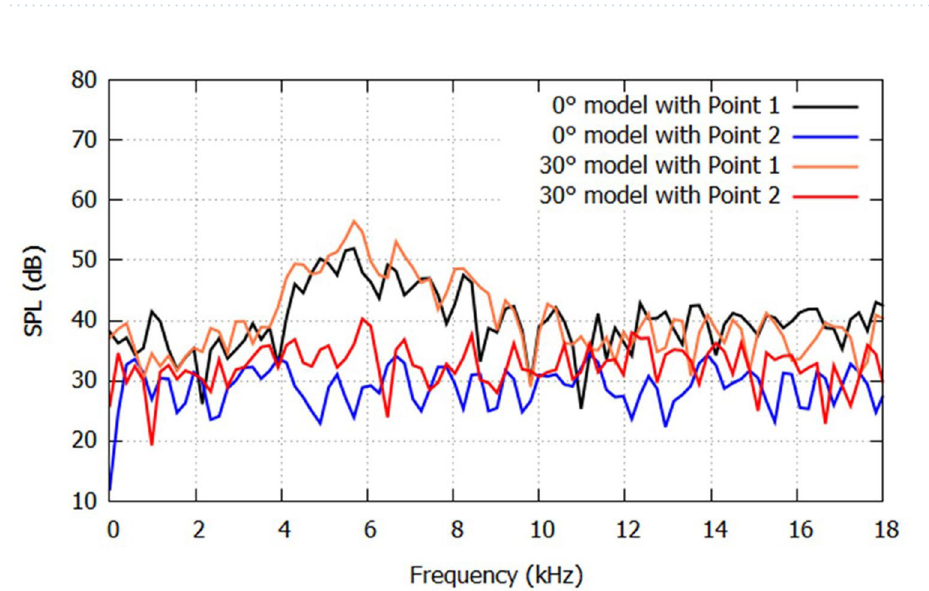
Figure 6. Fast Fourier transforms of the velocity fluctuations at ( a,c ) 5 kHz and ( b,d ) 10 kHz for the ( a,b ) 0° and ( c,d ) 30° models.